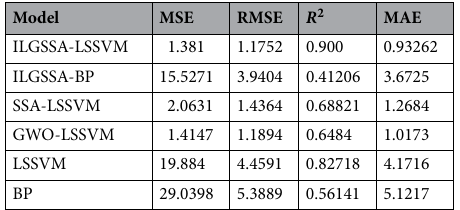
Table 2. Comparison table of evaluation indexes of various soft sensing